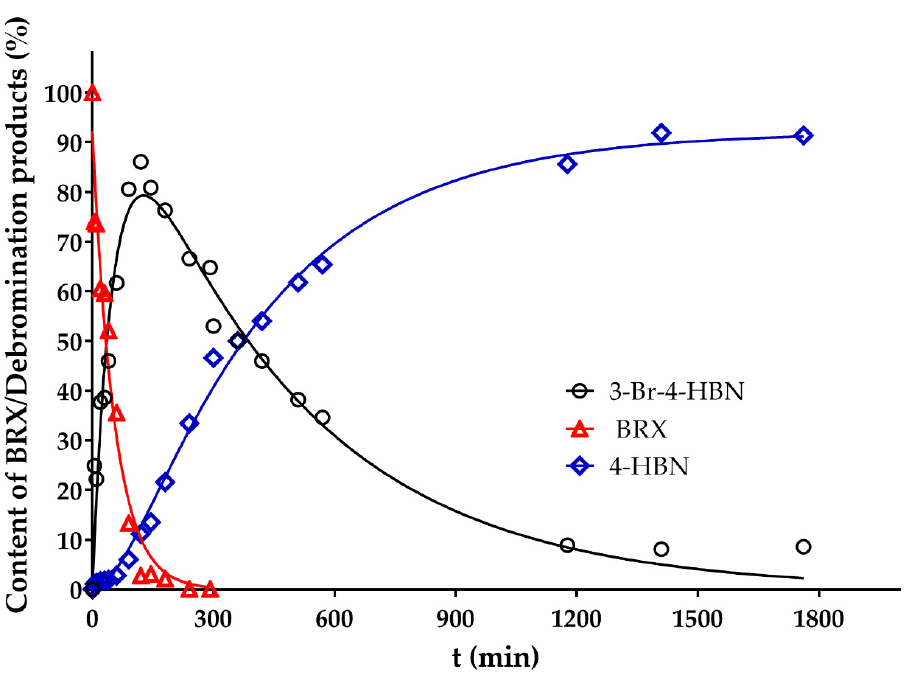
Figure 10. HDB rate of 5 mM BRX in 20 mM NaOH using Cu 2 O (3.1 g/L) under the coaction of NaBH 4 (8 g/L).